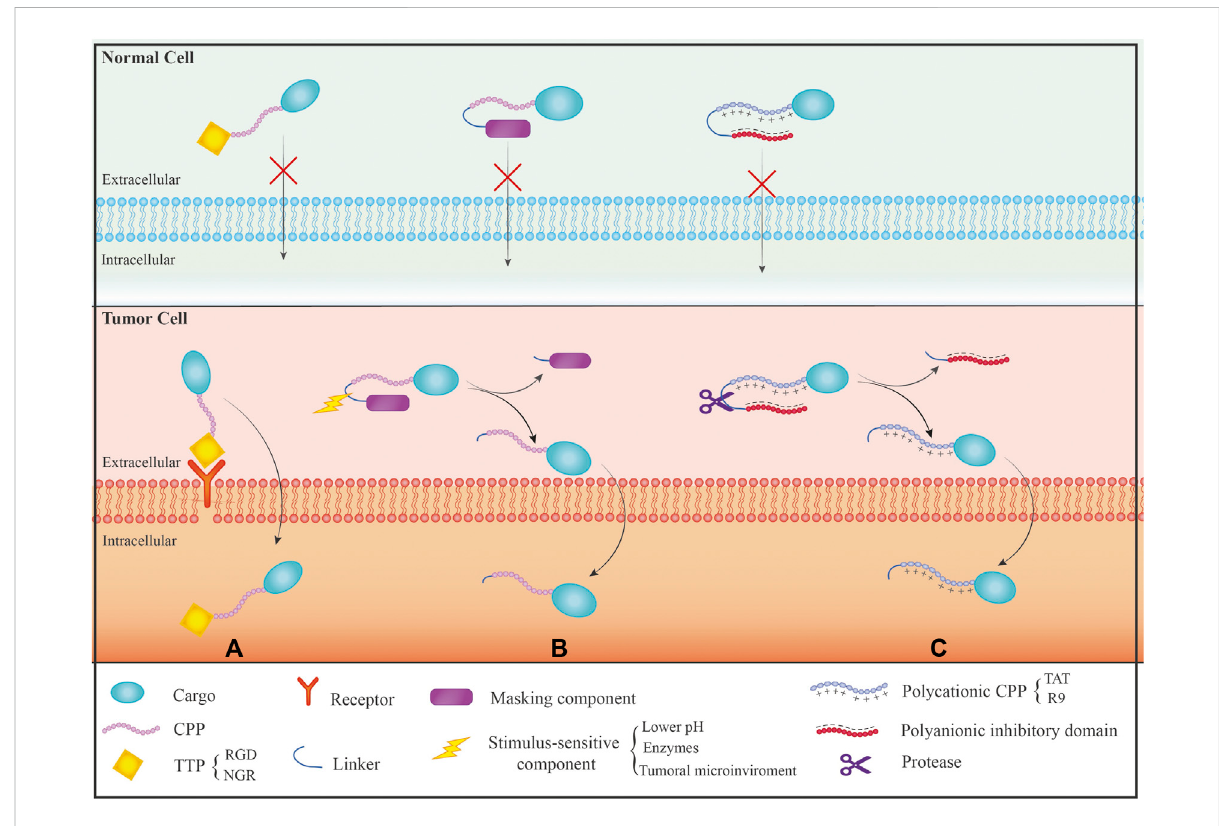
FIGURE 1 DifferentmechanismsofCPPsspeci fi cityonthenormalandcancercells: (A) Theuseoftumortargetingpeptide(TTP)thathasreceptoronlyon the surface of tumor cells resulting in the effect of CPPs on speci fi c target cells; (B) The use of activated CPP (ACPP) mechanism that causes activationofCPPsjustinresponsetoamotivatingfactor; (C) Theuseofpolyanionic inhibitorandlinker,whichlinkerisonlyremovedbytheprotease present in the target site, and then CPP interacts with the membrane to enter the